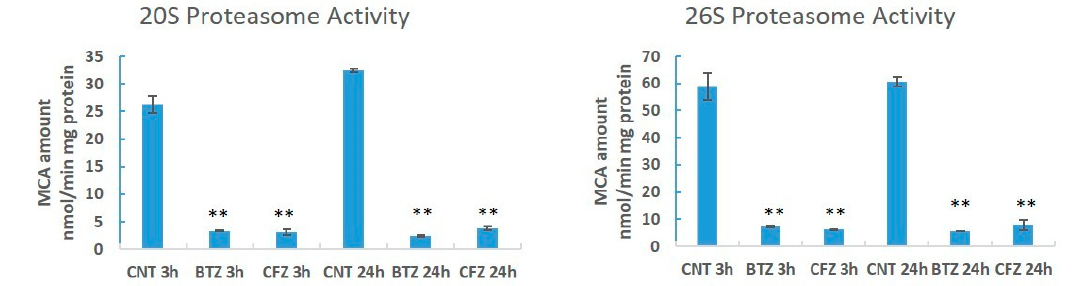
Figure 2. Chymotrypsin like proteasome activities in neuronal cells after BTZ and CFZ treatments. Values represent means ± SD, n = 3. ** p < 0.01 (CNT: